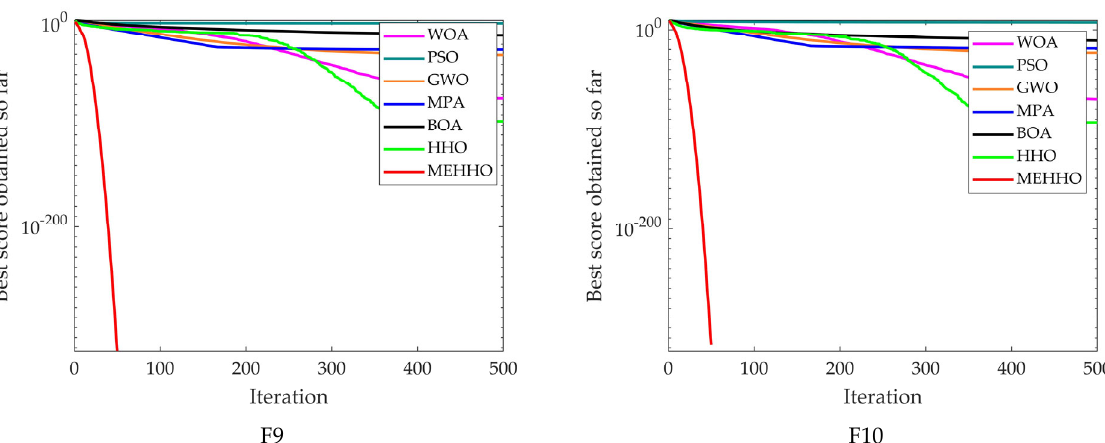
Figure 3. Convergence curves of unimodal functions (F1–F10).